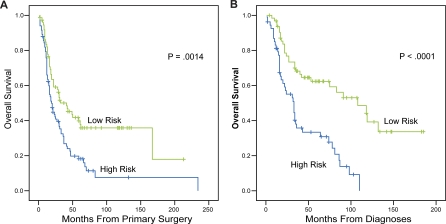
Kaplan-Meier Survival Curves for the Patients Predicted to Have Above or Below Median Risk of Death Due to Ovarian Cancer(A) Present study, median survival of 19 mo versus 41 mo (p = 0.0014, log-rank), permutation p-value = 0.015.(B) Dressman et al. [9], median survival of 33 mo versus 108 mo (p < 0.0001, log-rank), permutation p-value = 0.007.